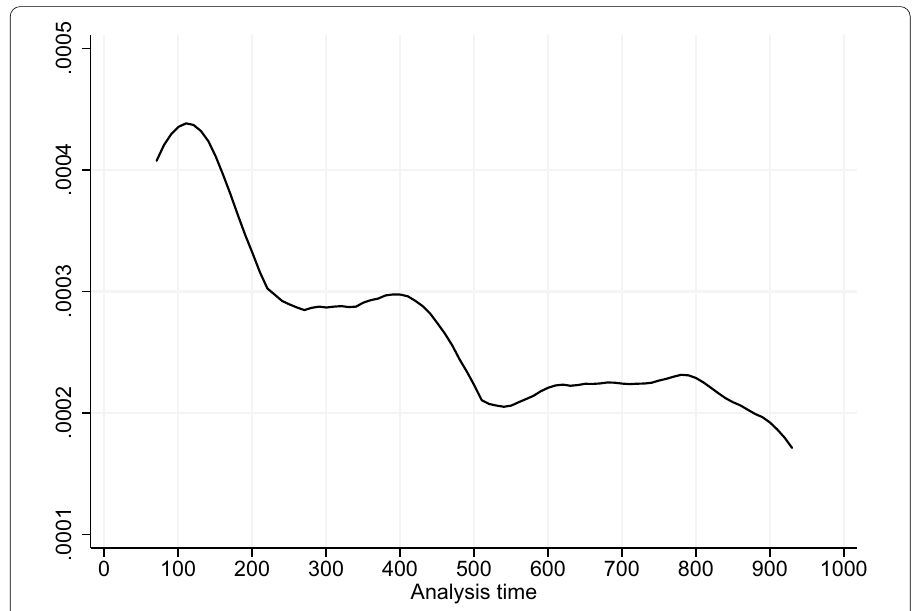
Fig. 2 Smoothed Kaplan‑Meier estimate of the hazard function (Source: SIAB 2000‑2013. Note: N apprenticeships with 19,697 incidences of non‑completion.)